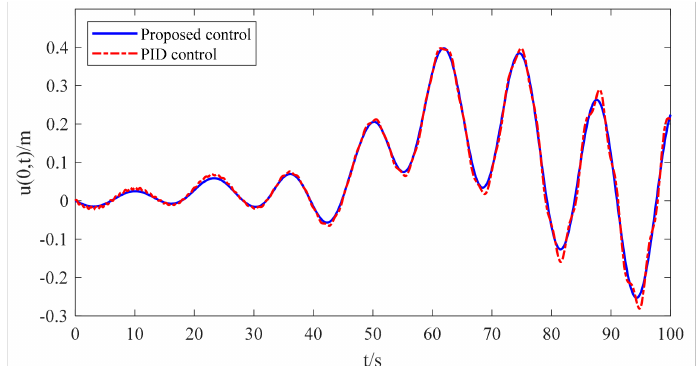
Figure 9. Hydraulic cylinder piston